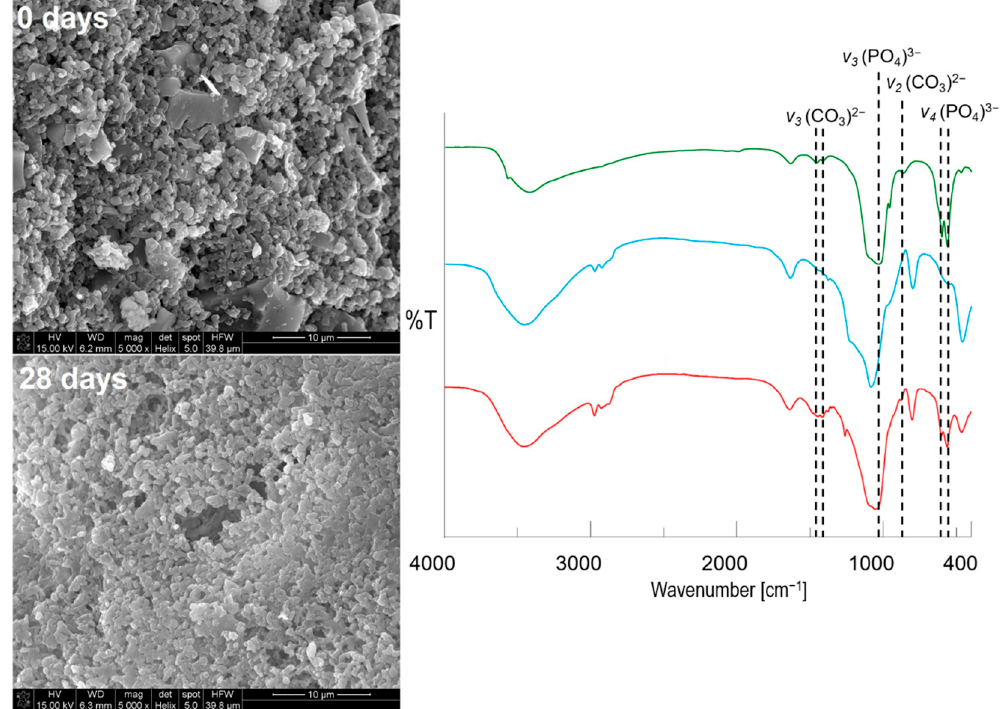
Figure 8. The SEM-EDX micrographs (×5000 magnifications) with corresponding FTIR spectra of obtained pellets before (blue) and after (red) immersion in SBF together with a hydroxyapatite reference sample (green) (types of vibrational modes: υ 2 (bending), υ 3 (stretching) of (CO 3 ) 2 − ; υ 3 (stretching), υ 4 (bending) of (PO 4 ) 3 − .